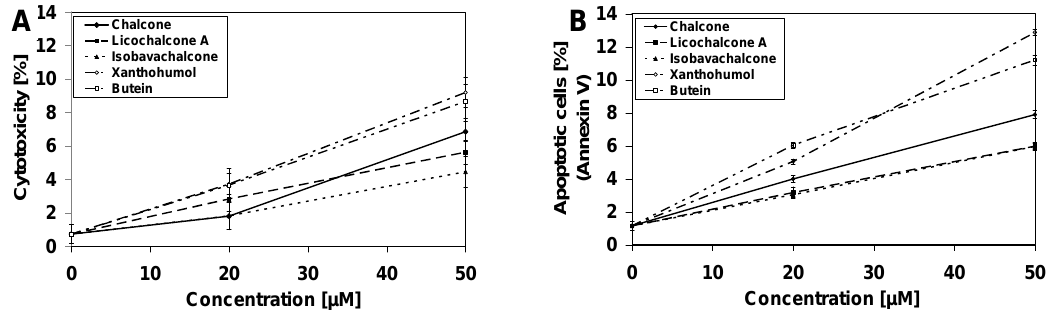
Figure 2. Cytotoxic and apoptotic effects of chalcones on LNCaP prostate cancer cells. The cancer cells were incubated for 48 hours with five chalcones: chalcone, licochalcone-A, isobavachalcone, xanthohumol and butein at the concentrations of 20 μ M and 50 μ M. The values represent mean ± SD of three independent experiments performed in quadruplicate (n = 12) for cytototoxicity, or in duplicate (n = 6) for apoptosis (p < 0.05). (A) Cytotoxic activity of chalcones in LNCaP cells. The percentage of cell death was measured by MTT cytotoxicity assay. (B) Chalcone-induced apoptosis in LNCaP cells. Detection of apoptotic cell death by annexin V-FITC staining using flow cytometry.